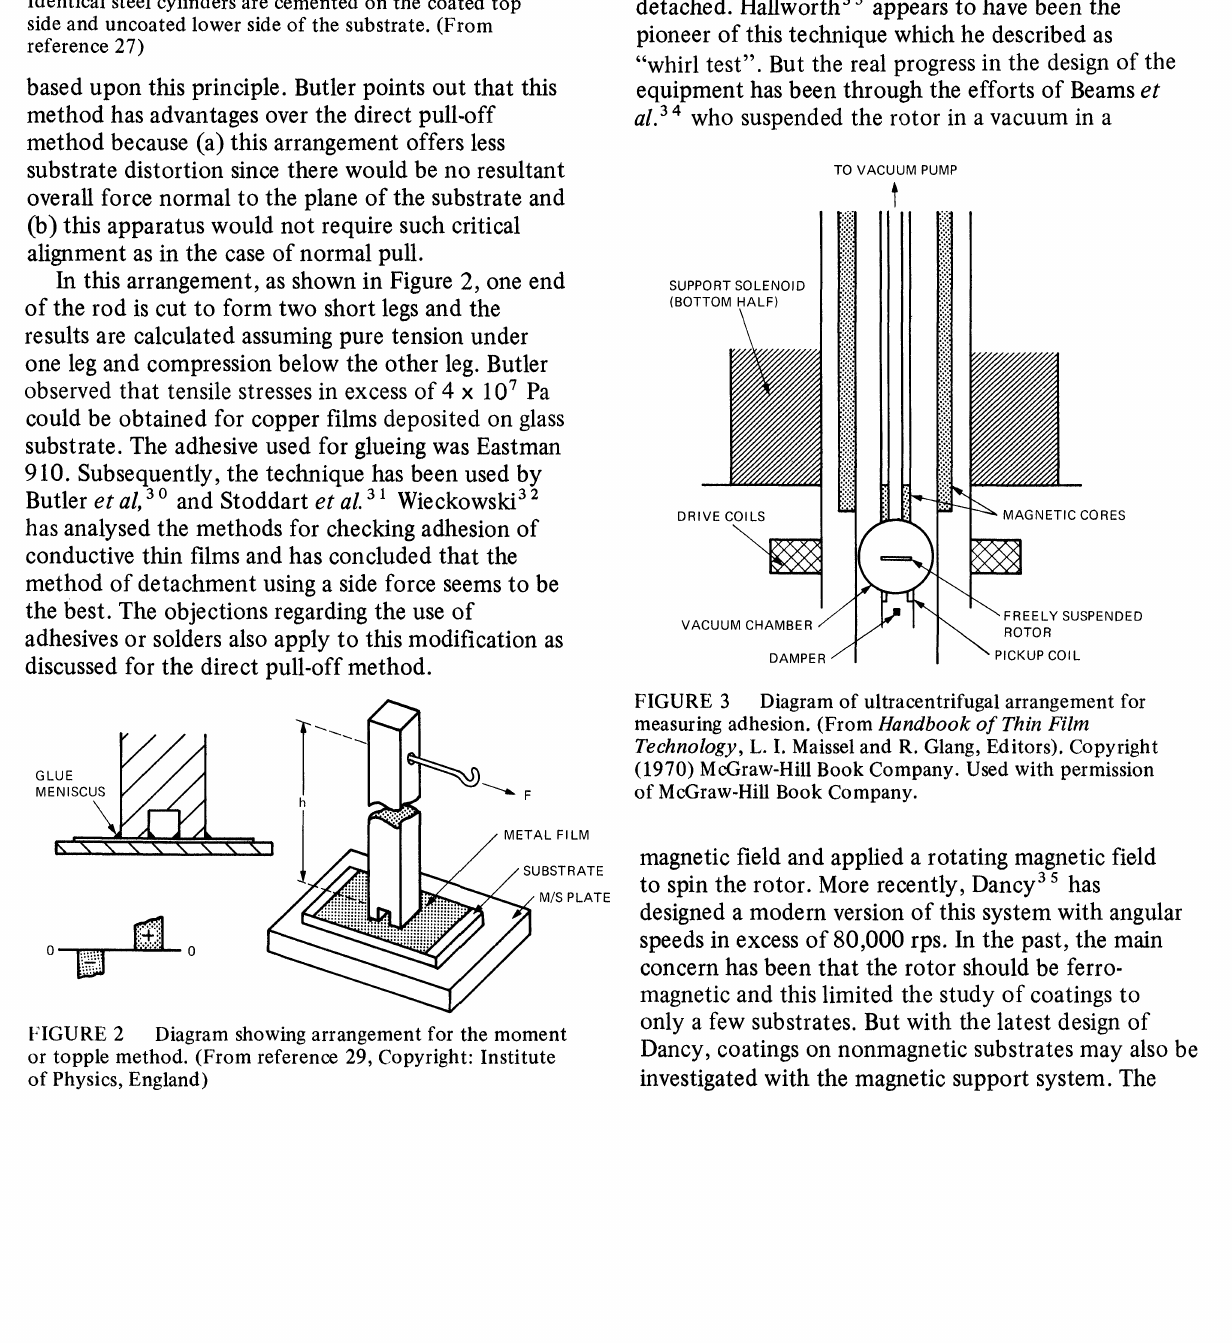
Diagram for adhesion test by application of a normal pulling force. The force F is applied at P1 and P2 with the force aligned through the center C of the substrate. Identical steel cylinders are cemented on the coated top side and uncoated lower side of the substrate. (From reference 27)